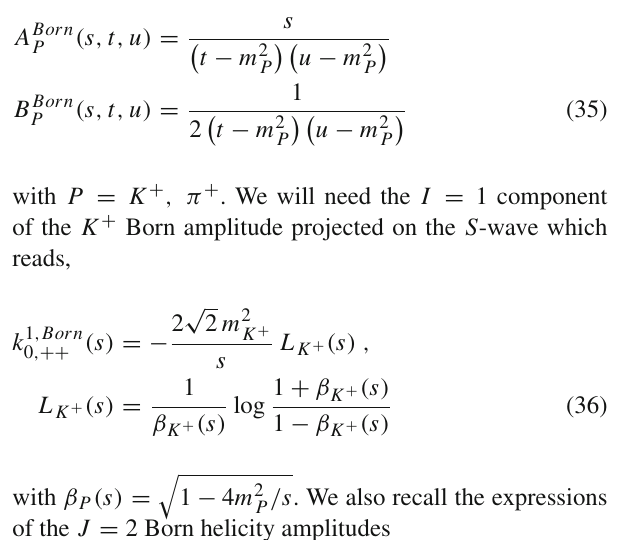
A left hand cut in the γ γ partial-waves is generated by singu- larities in the cross-channels γ P 1 → γ P 2 . In the case when P 1 = P 2 = K + or π + the leading singularity is the kaon